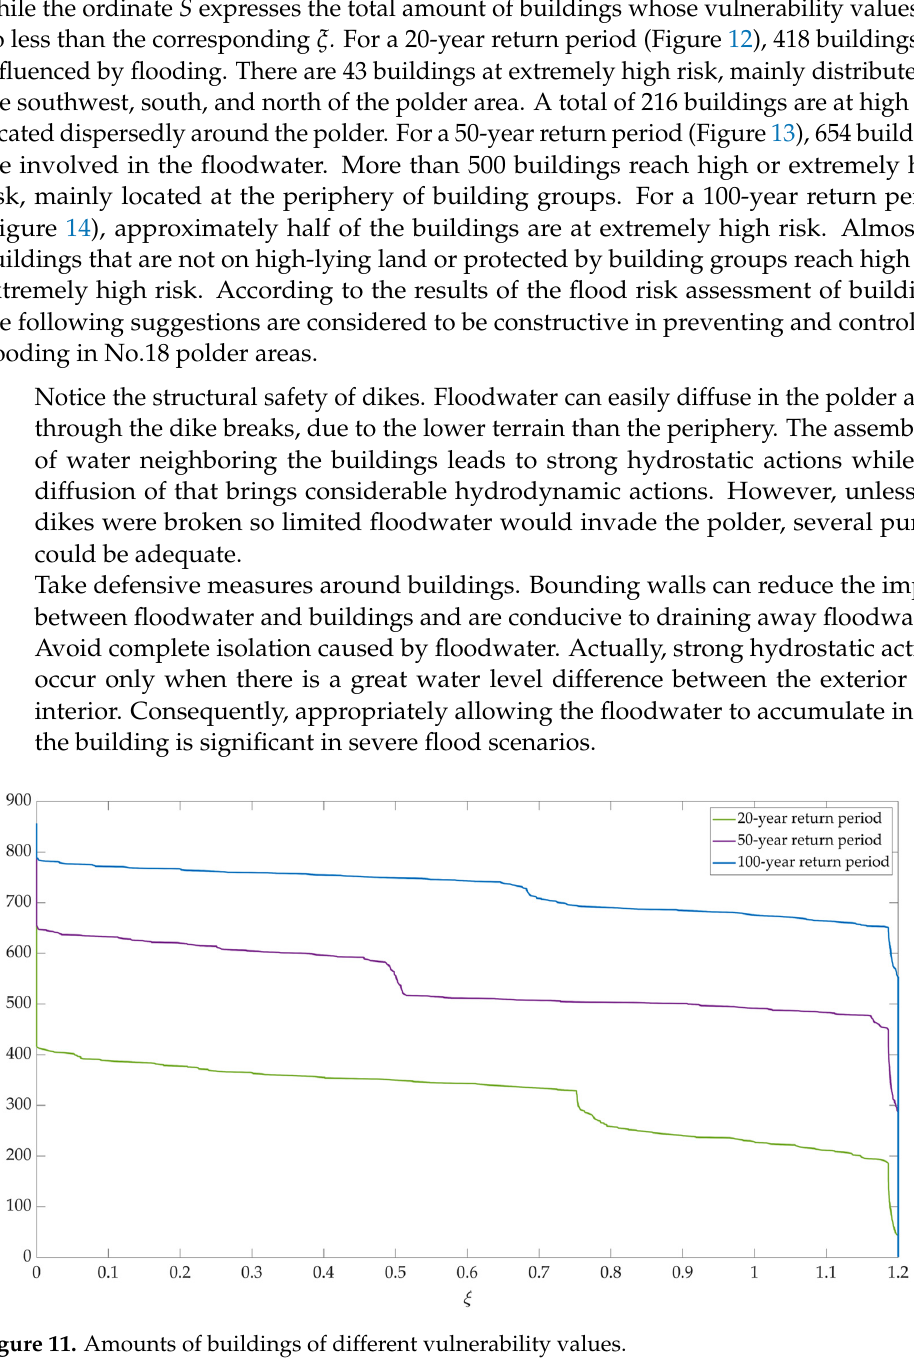
Figure 11. Amounts of buildings of different vulnerability values.